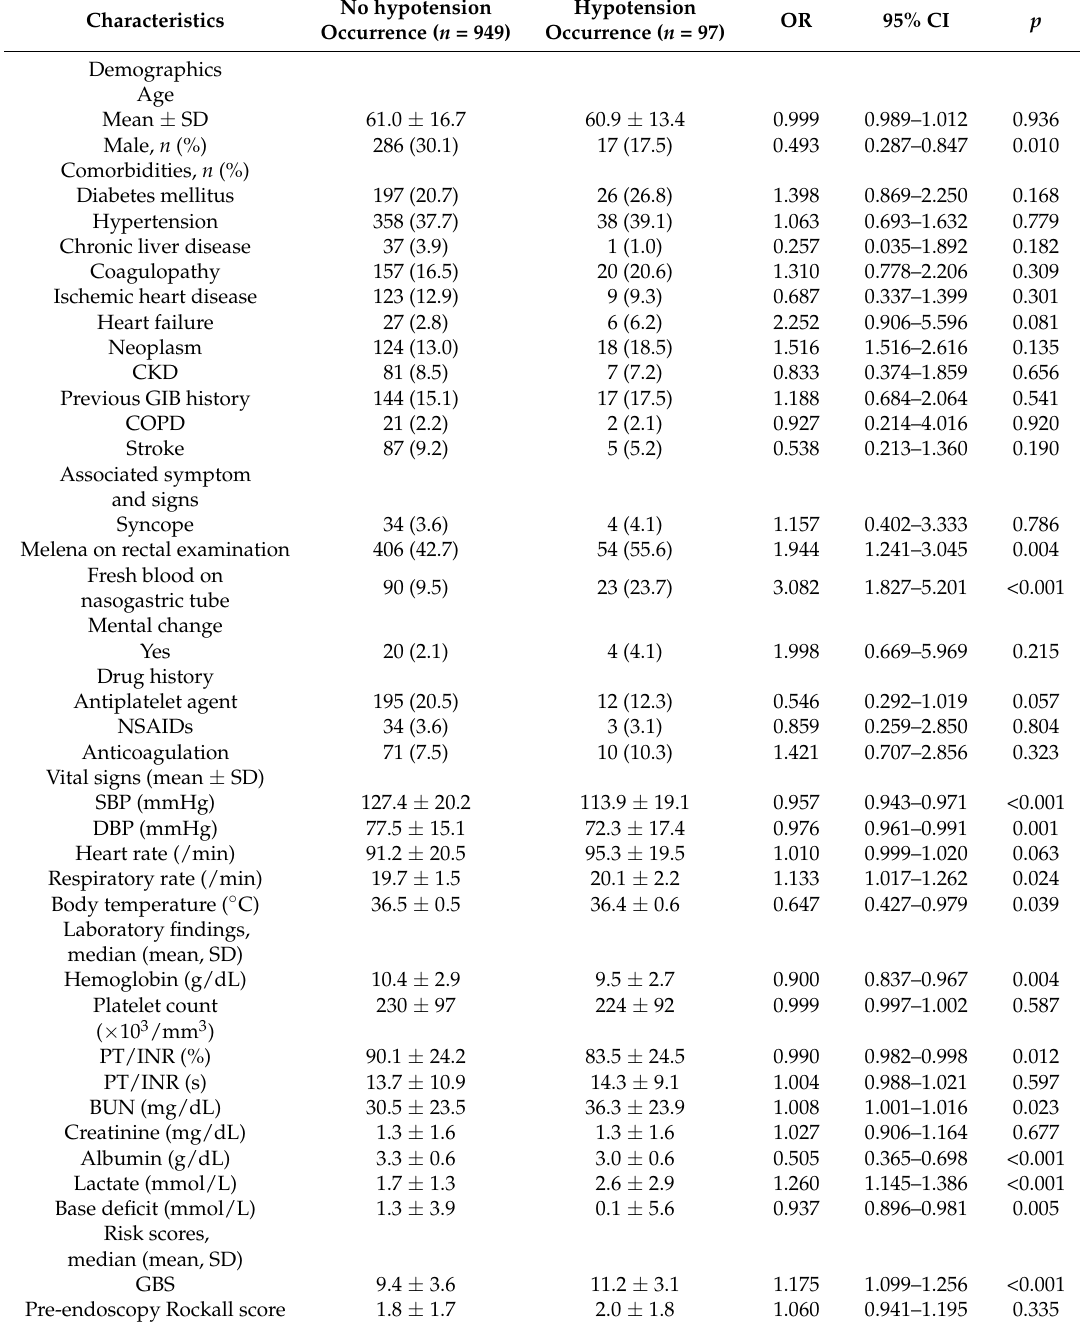
Table 1. Univariable analysis model for predicting the occurrence of hypotension in the development set